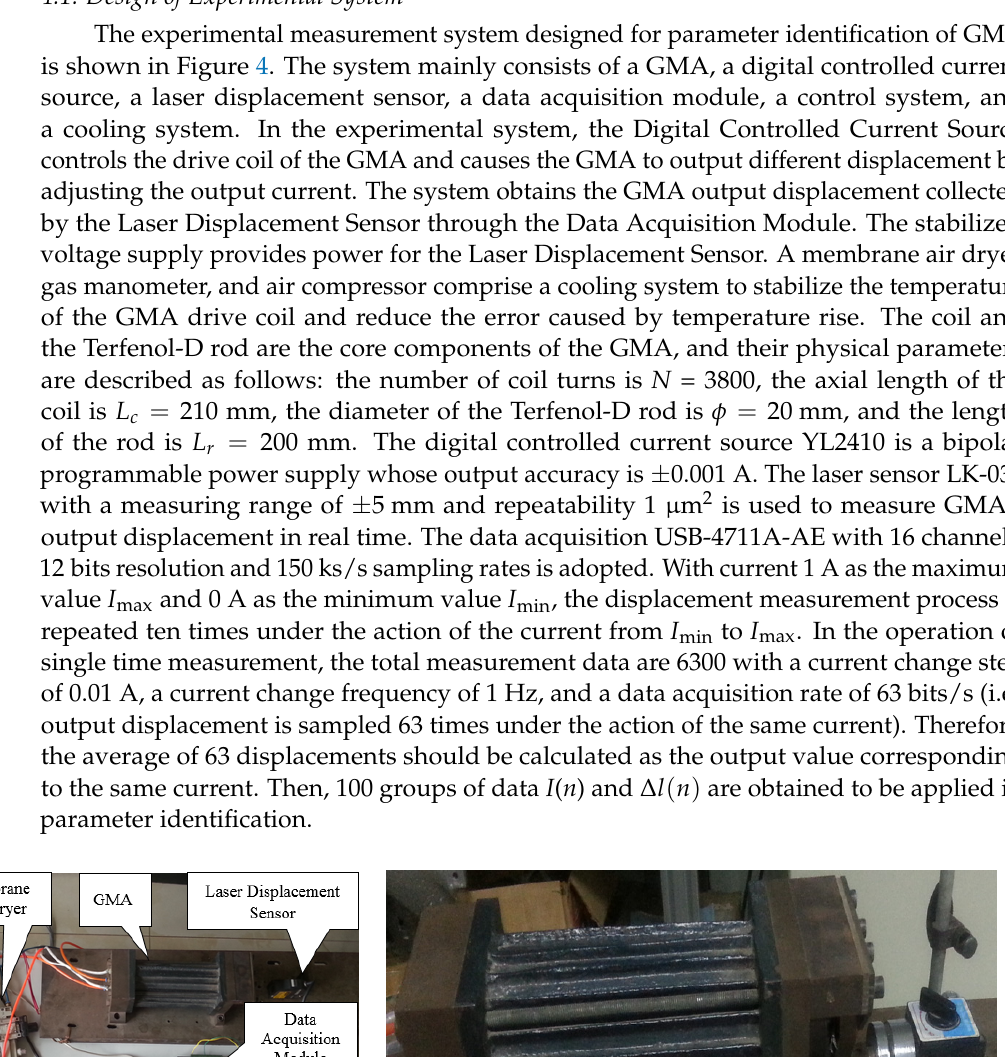
( c ) Figure 5. Identification evolution process: ( a ) GA; ( b ) PSO; ( c ) DE. Table 1. Repeated identification results of the GA. Parameter